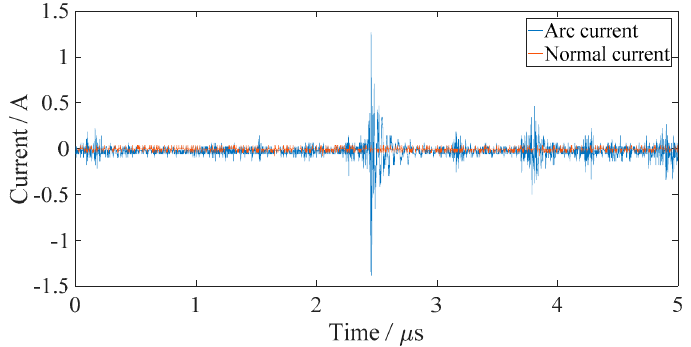
Figure 9. Current waveform in normal and arc fault conditions.